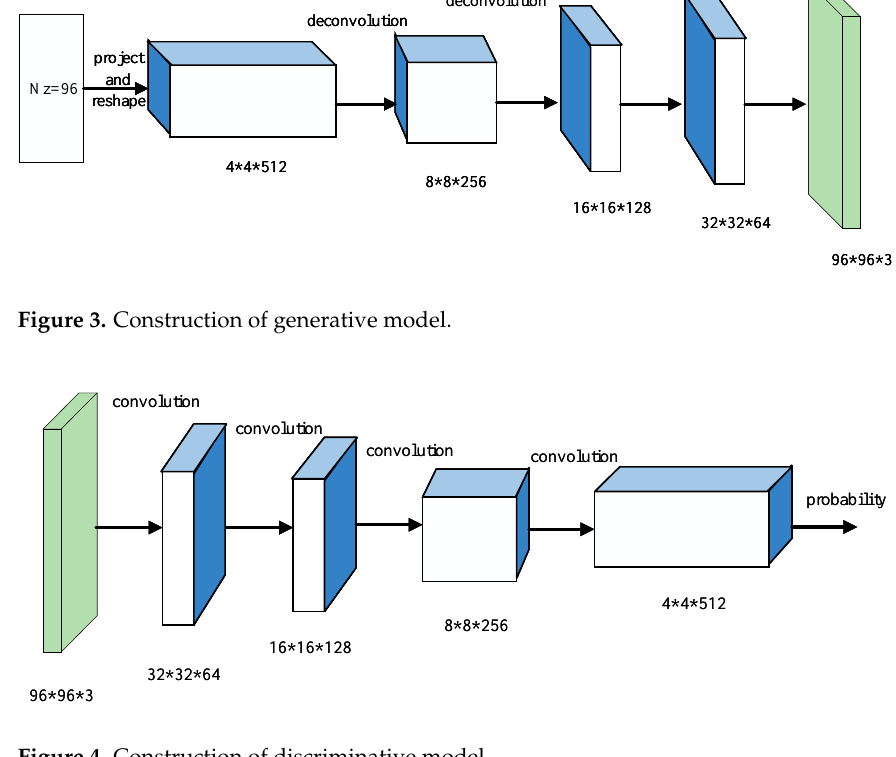
Figure 4. Construction of discriminative